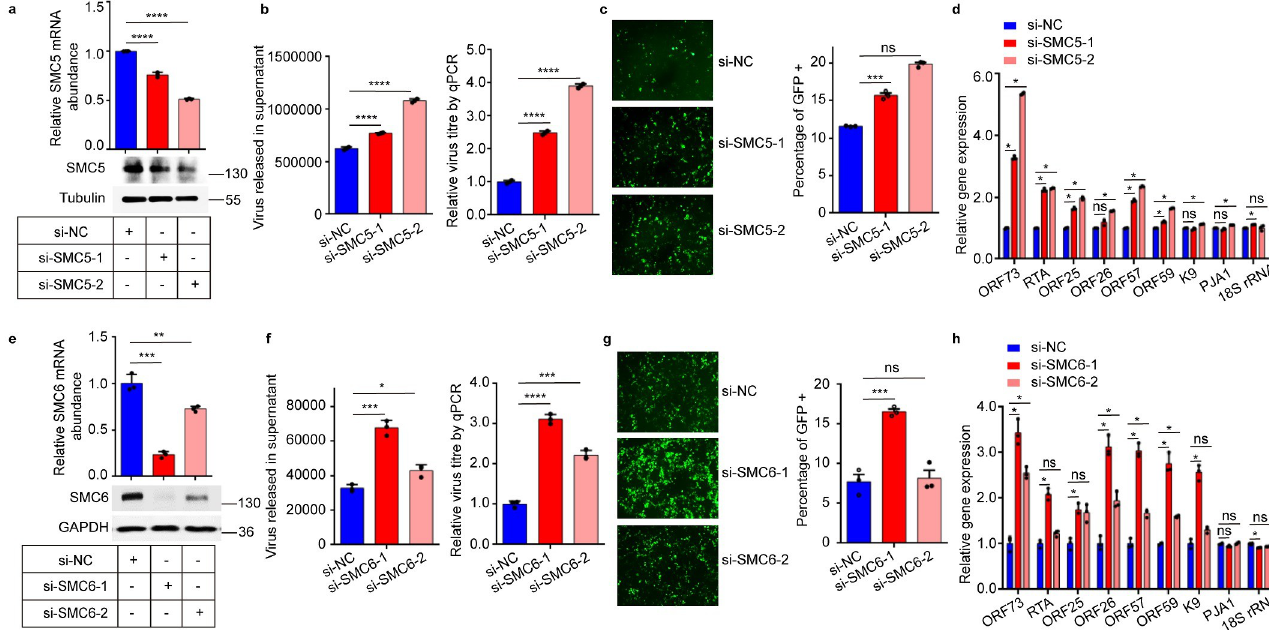
Fig 2. Knockdown of SMC5 and SMC6 promotes KSHV lytic replication. (a) iSLK.RGB cells were transfected with control siRNA and two siRNAs targeting human SMC5. 48h post-transfection, the knockdown efficiency was determined via qPCR and western blots. (b) DNase-treated viral DNAs from culture supernatants were analyzed via qPCR. Left panel, viral DNA copy numbers were quantified by using K9 primers. Right panel, pGL3-luc plasmid DNA was added during viral DNAs extraction to ensure the quality of DNA extraction. Relative DNA copy numbers were measured via qPCR using primers for K9 and pGL3. The values of control were set as 1. (c) Cell supernatants of SMC5-knockdown cells were collected and infected with HEK293T cells. 24h later, KSHV-infected GFP-positive cells were observed by fluorescence microscope and analyzed by flow cytometry. (d) SMC5-knockdown and control cells were treated with Dox and NaB for 48h, and KSHV gene transcription was analyzed via qPCR. (e-h) Effect of knockdown SMC6 on KSHV lytic replication, which is similar to (a-d). Representative results from three biological replicates are presented. Error bars indicate SD. Data were analyzed with Student’s multiple t tests ( � p < 0.05, �� p < 0.01, ��� p < 0.001, ���� p <